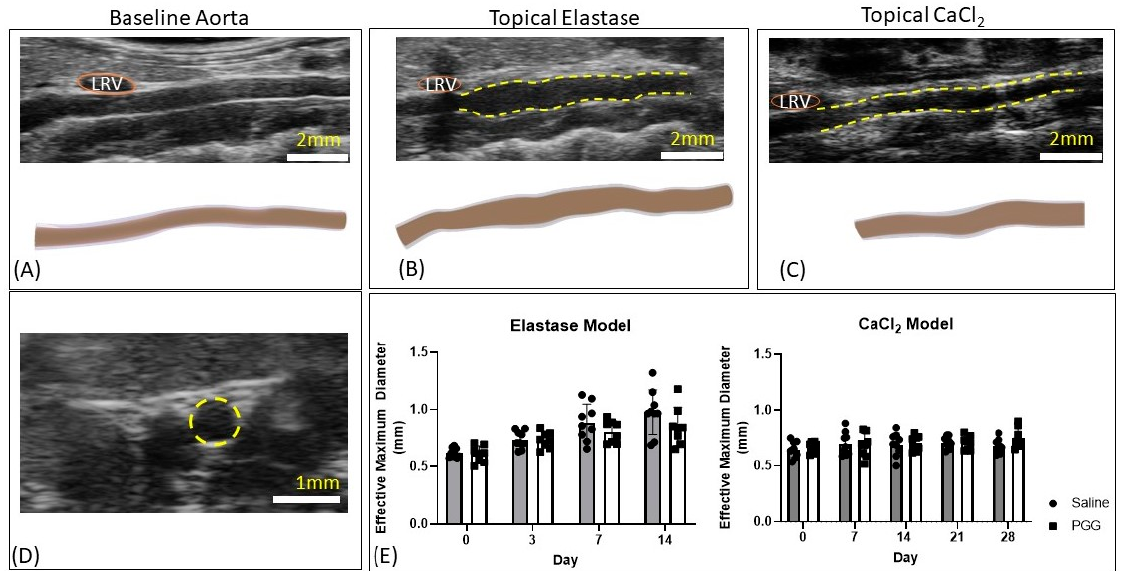
Figure 3. Diameter changes in the topical elastase and topical CaCl 2 models. ( A ) Longitudinal ultrasound image and three-dimensional rendering of the baseline infrarenal aorta. LRV, left renal vein. ( B ) Representative longitudinal ultrasound image and three-dimensional rendering of an aorta from the topical elastase group 14 days after aortic injury. Yellow dashed lines indicate where treatment, either saline or PGG, was applied. ( C ) Representative longitudinal ultrasound image and three-dimensional rendering of an aorta from the topical CaCl 2 group 28 days after aortic injury. Yellow dashed lines indicate where treatment, either saline or PGG, was applied. ( D ) Example short axis ultrasound image used to measure luminal area in systole and diastole to assess effective maximum diameter, as shown in Equation (1). ( E ) No differences between saline-treated and PGG-treated vessels were seen in either the elastase or CaCl 2 -treated vessels. Elastase-treated vessels increased in diameter over the two-week observation period.